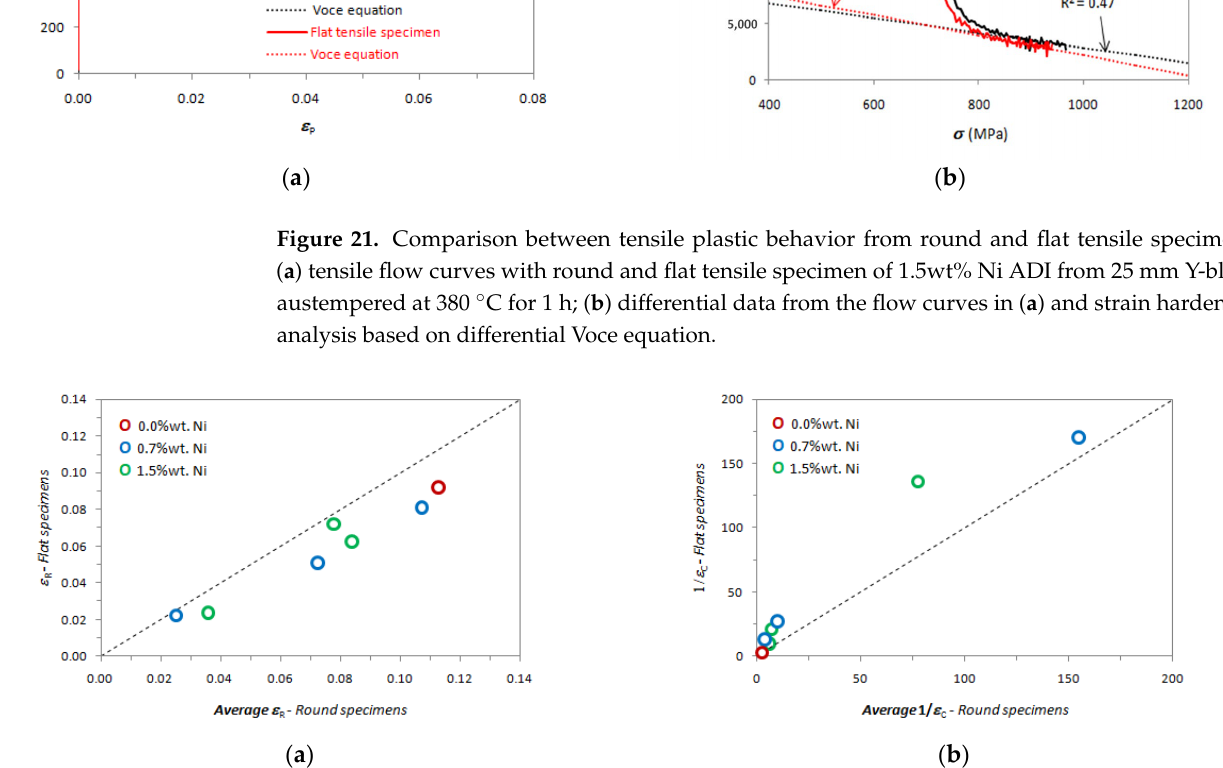
Figure 22. ( a ) Strains to rupture ( ε R ) comparison from round and flat tensile specimens from 25 mm Y-block ADIs for different Ni contents and austempering conditions: ε R —flat tensile specimens vs. average ε R —round tensile specimens; ( b ) 1/ ε c —flat tensile specimens vs. average 1/ ε c —round tensile specimens (0.0 wt% Ni ausferrite austempered at 310 ◦ C for 3 h and 250 ◦ C for 6 h are